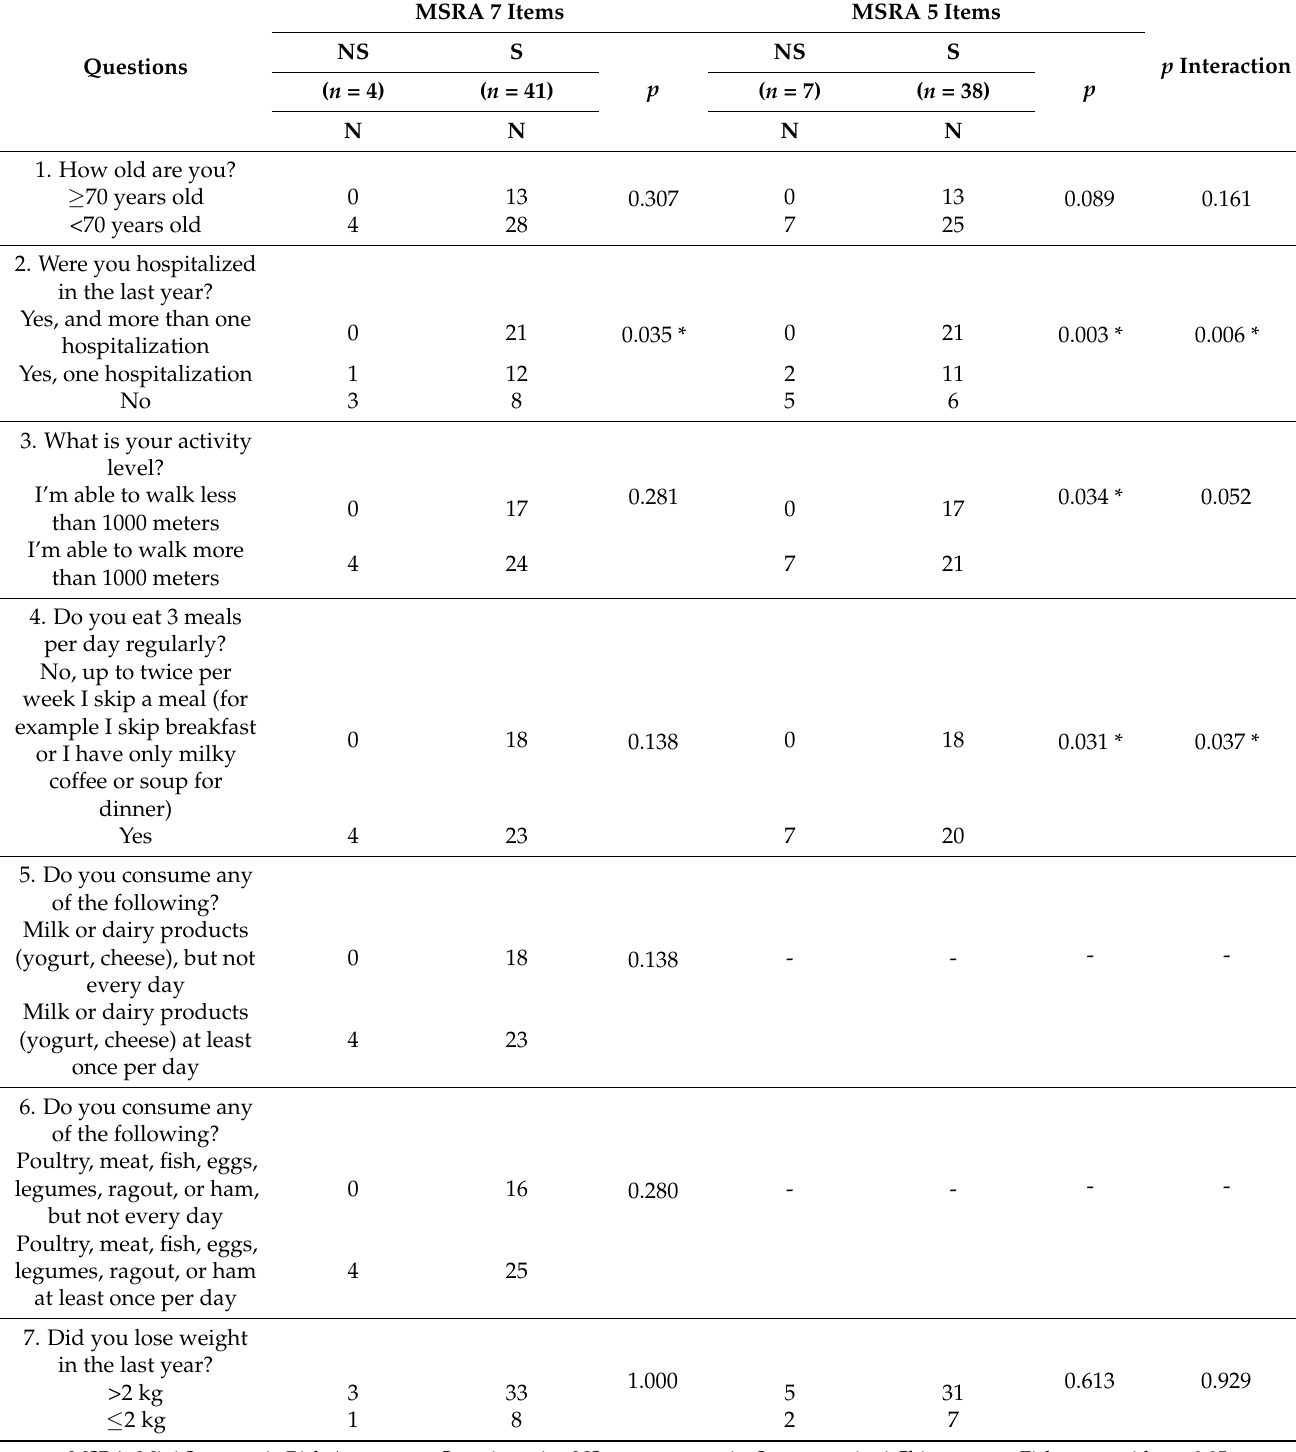
Table 2. Number of patients without risk and at risk of sarcopenia according to MSRA of 7 and 5